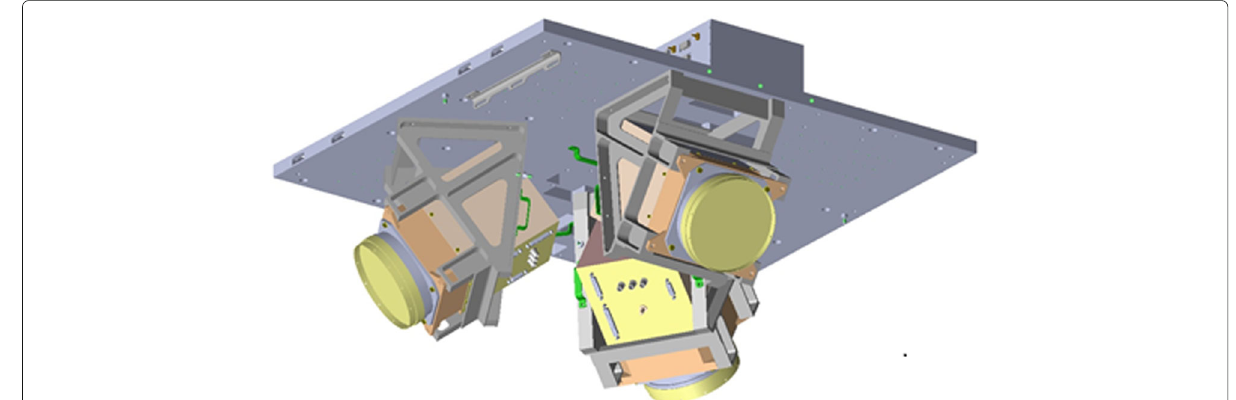
Fig. 9 The general view of the location of the GFM detector units